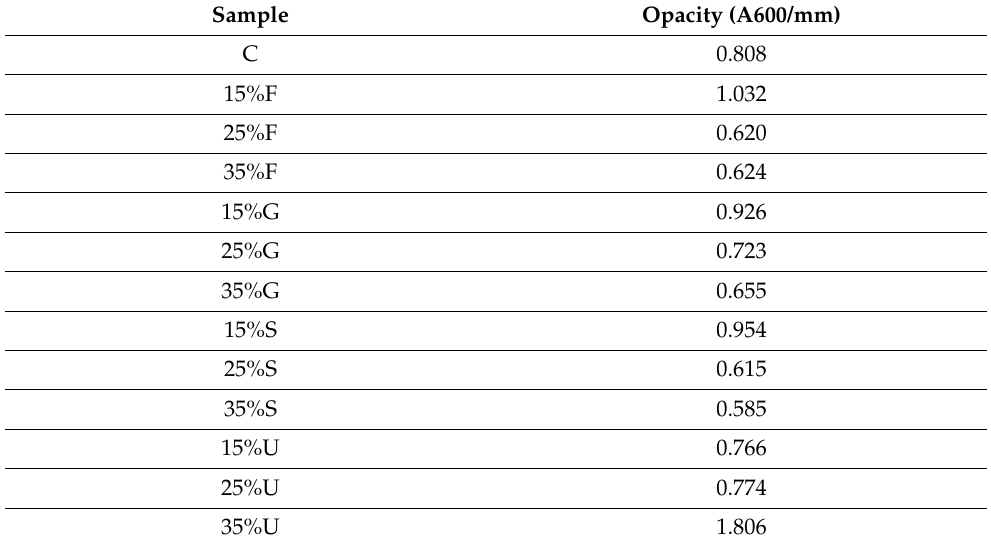
Table 2. Transparency of wheat starch-based films and various plasticizers.